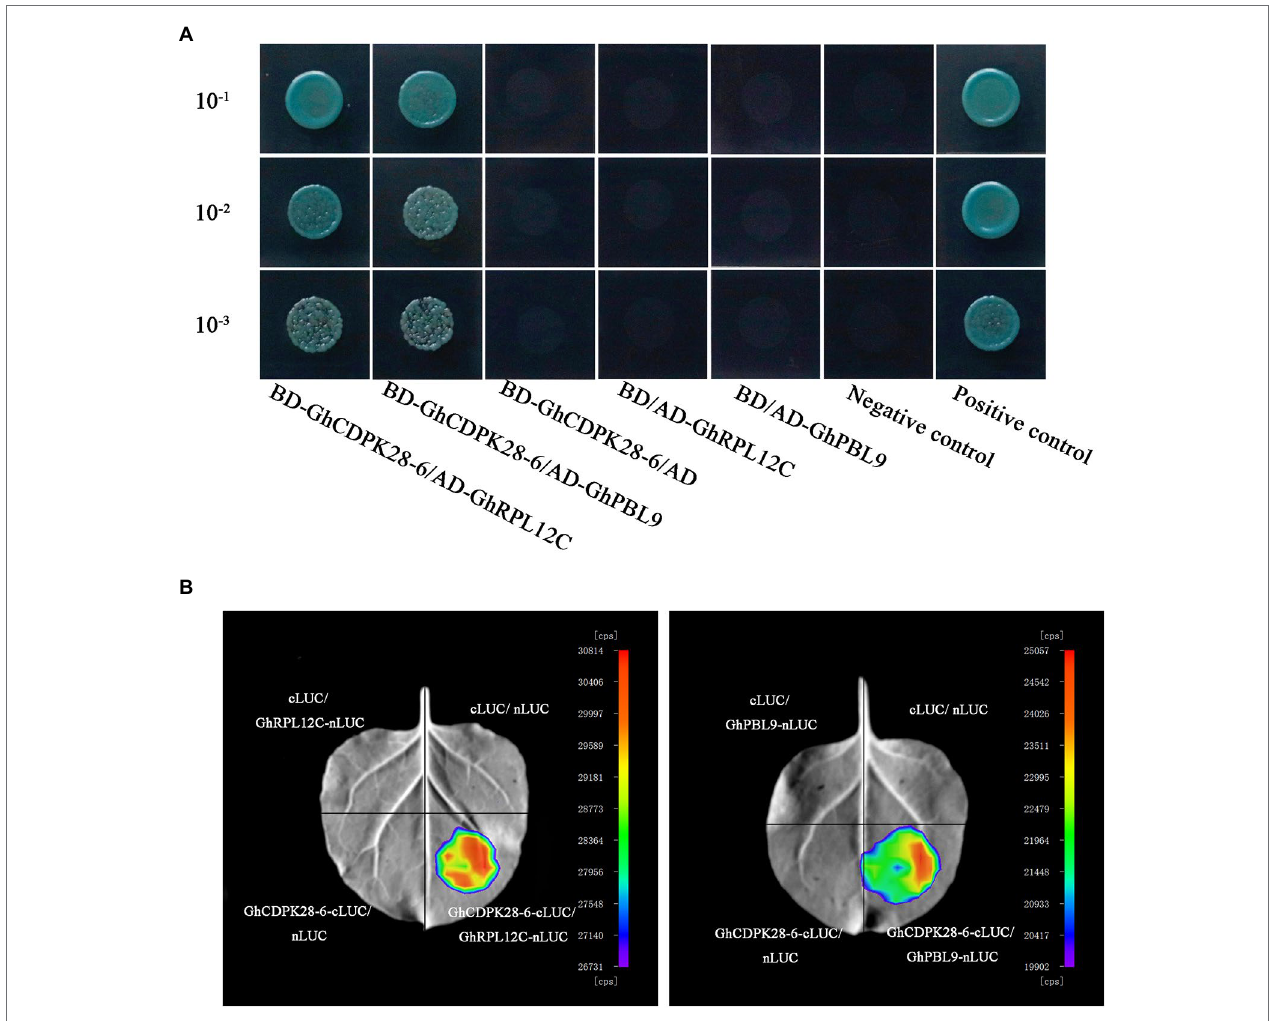
FIGURE 10 | GhCDPK28-6 interacts with GhPBL9 and GhRPL12C. (A) Yeast two-hybrid assays of the interactions of GhCDPK28-6 with GhPBL9 and GhRPL12C. Transformants were grown on SD/-Leu/-Trp/-Ade/-His (+ X- α -gal) media. pGBKT7-53/pGADT7-RecT was used as the positive control. pGBKT7-Lam/ pGADT7-RecT were used as negative controls. (B) LCI was used to detect the interaction of GhCDPK28-6 with GhPBL9 and GhRPL12C in N. benthamiana